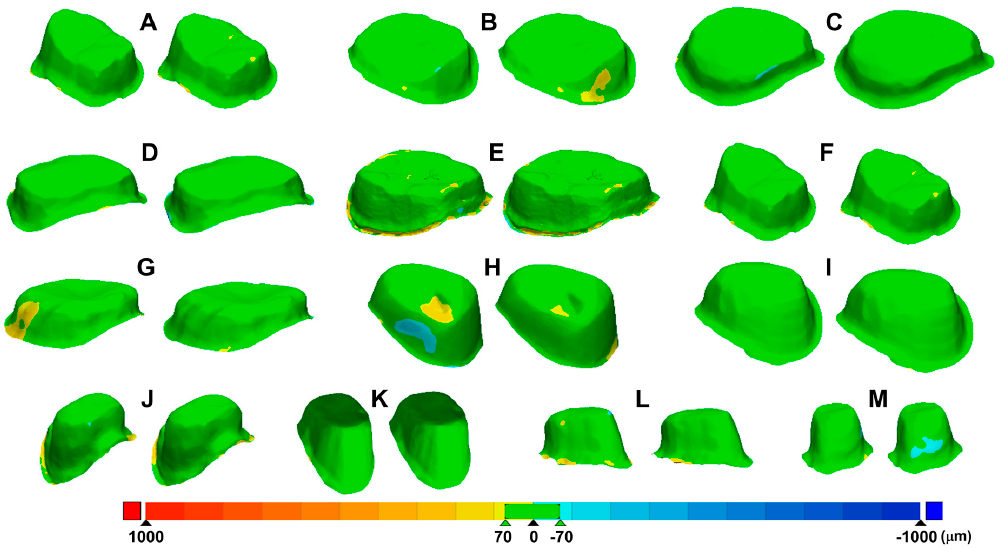
Figure 11. Box plot of root mean square between the CI dataset and datasets obtained using the AEGIS and CEREC scans.